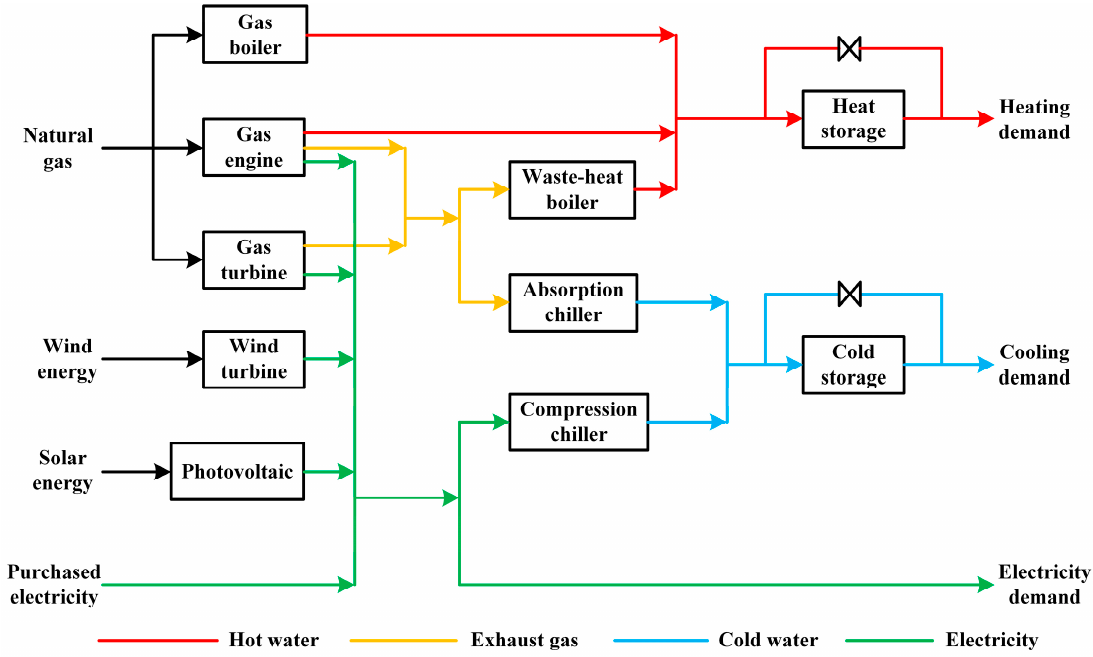
Figure 1. Superstructure of the distributed energy resource (DER)